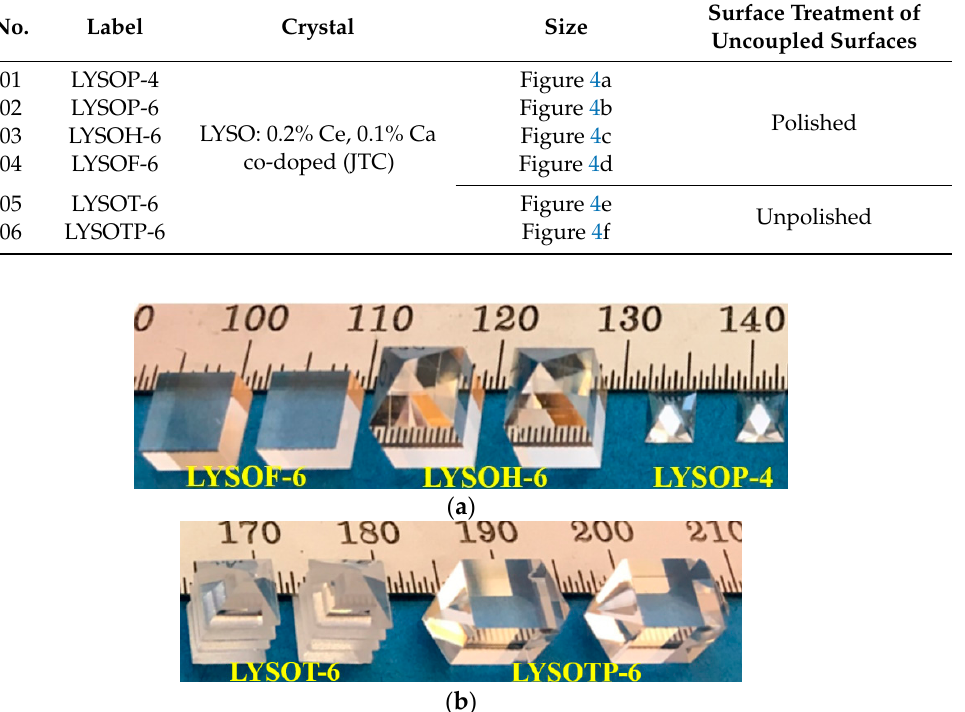
Table 3. Parameters of the odd-shaped LYSO crystals.